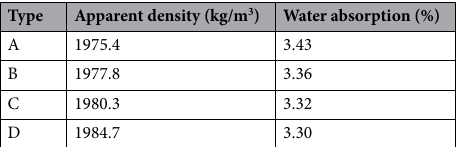
Table 5. Density and water absorption of hardened